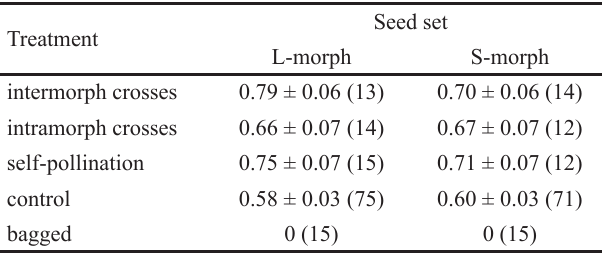
Table 2 – Seed set under five pollination treatments of Cordia subcordata in the Yongxing Island population. Numbers between brackets indicate the number of flowers.